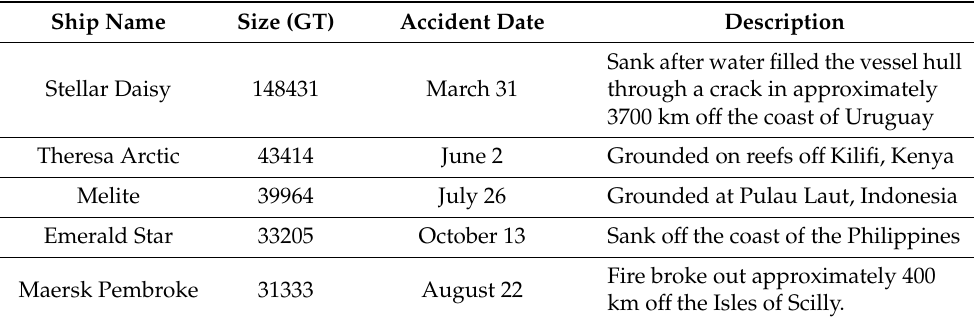
Table 3. List of the largest ships lost in 2017